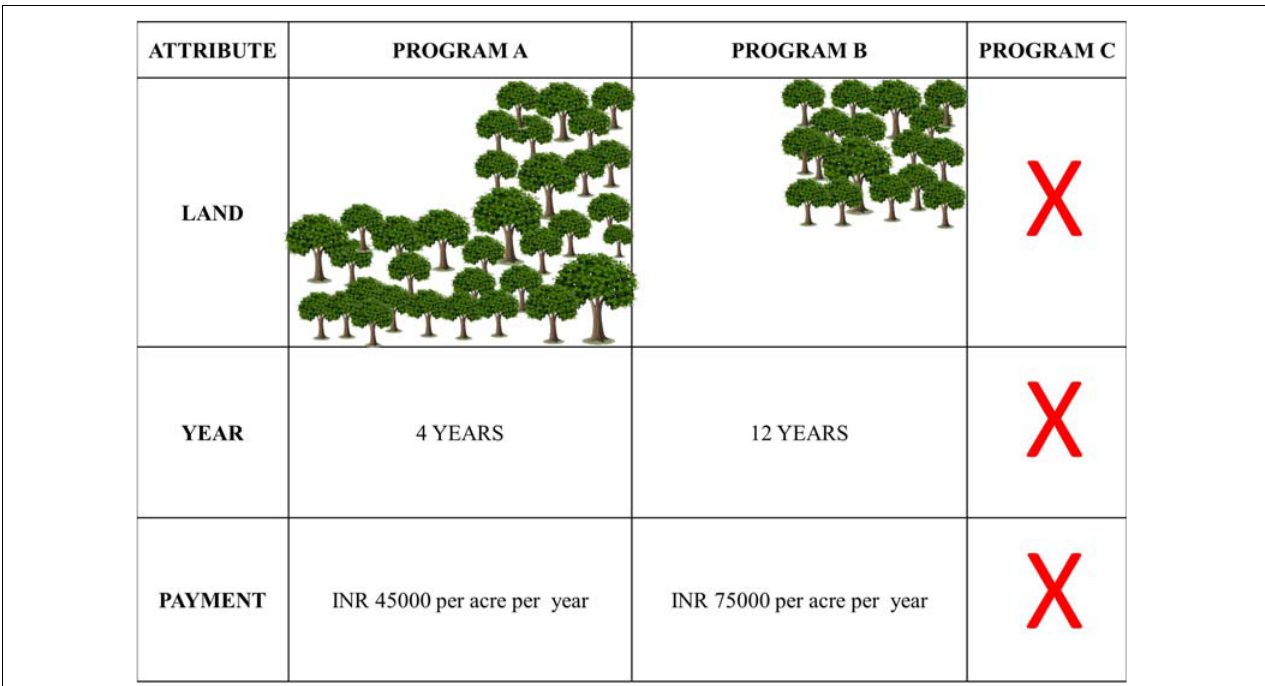
FIGURE 2 | Sample of choice card used in the choice experiment (based on study design used in Puri et al.,